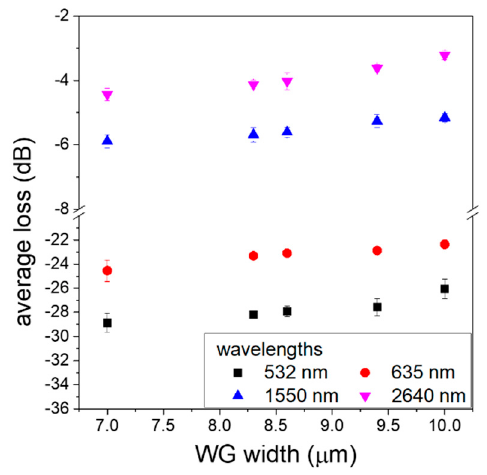
Figure 11. Coupling losses measured at 532 nm, 635 nm, 1550 nm, and 2640 nm for each WG width.